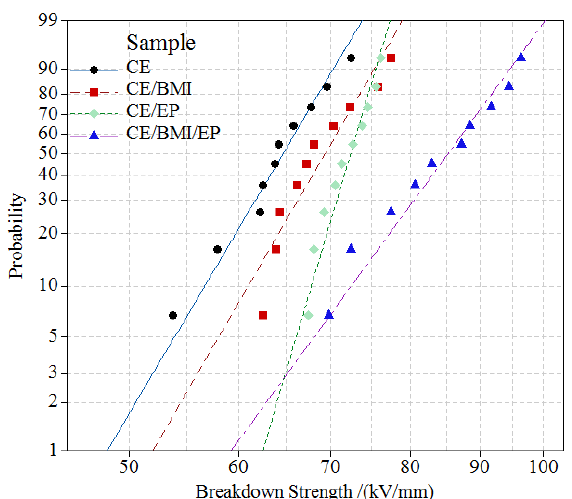
Figure 5. DBS fitted with 2-parameter Weibull statistics of pure CE and CE / EP, CE / BMI, and 262 CE / BMI / EP composites. 263 Table 2. Weibull distribution fitted 2-parameters in 95% confidence interval from the tested dielectric breakdown 264 fields: characteristic breakdown field E b at 63.2% probability and shape parameter β. 265